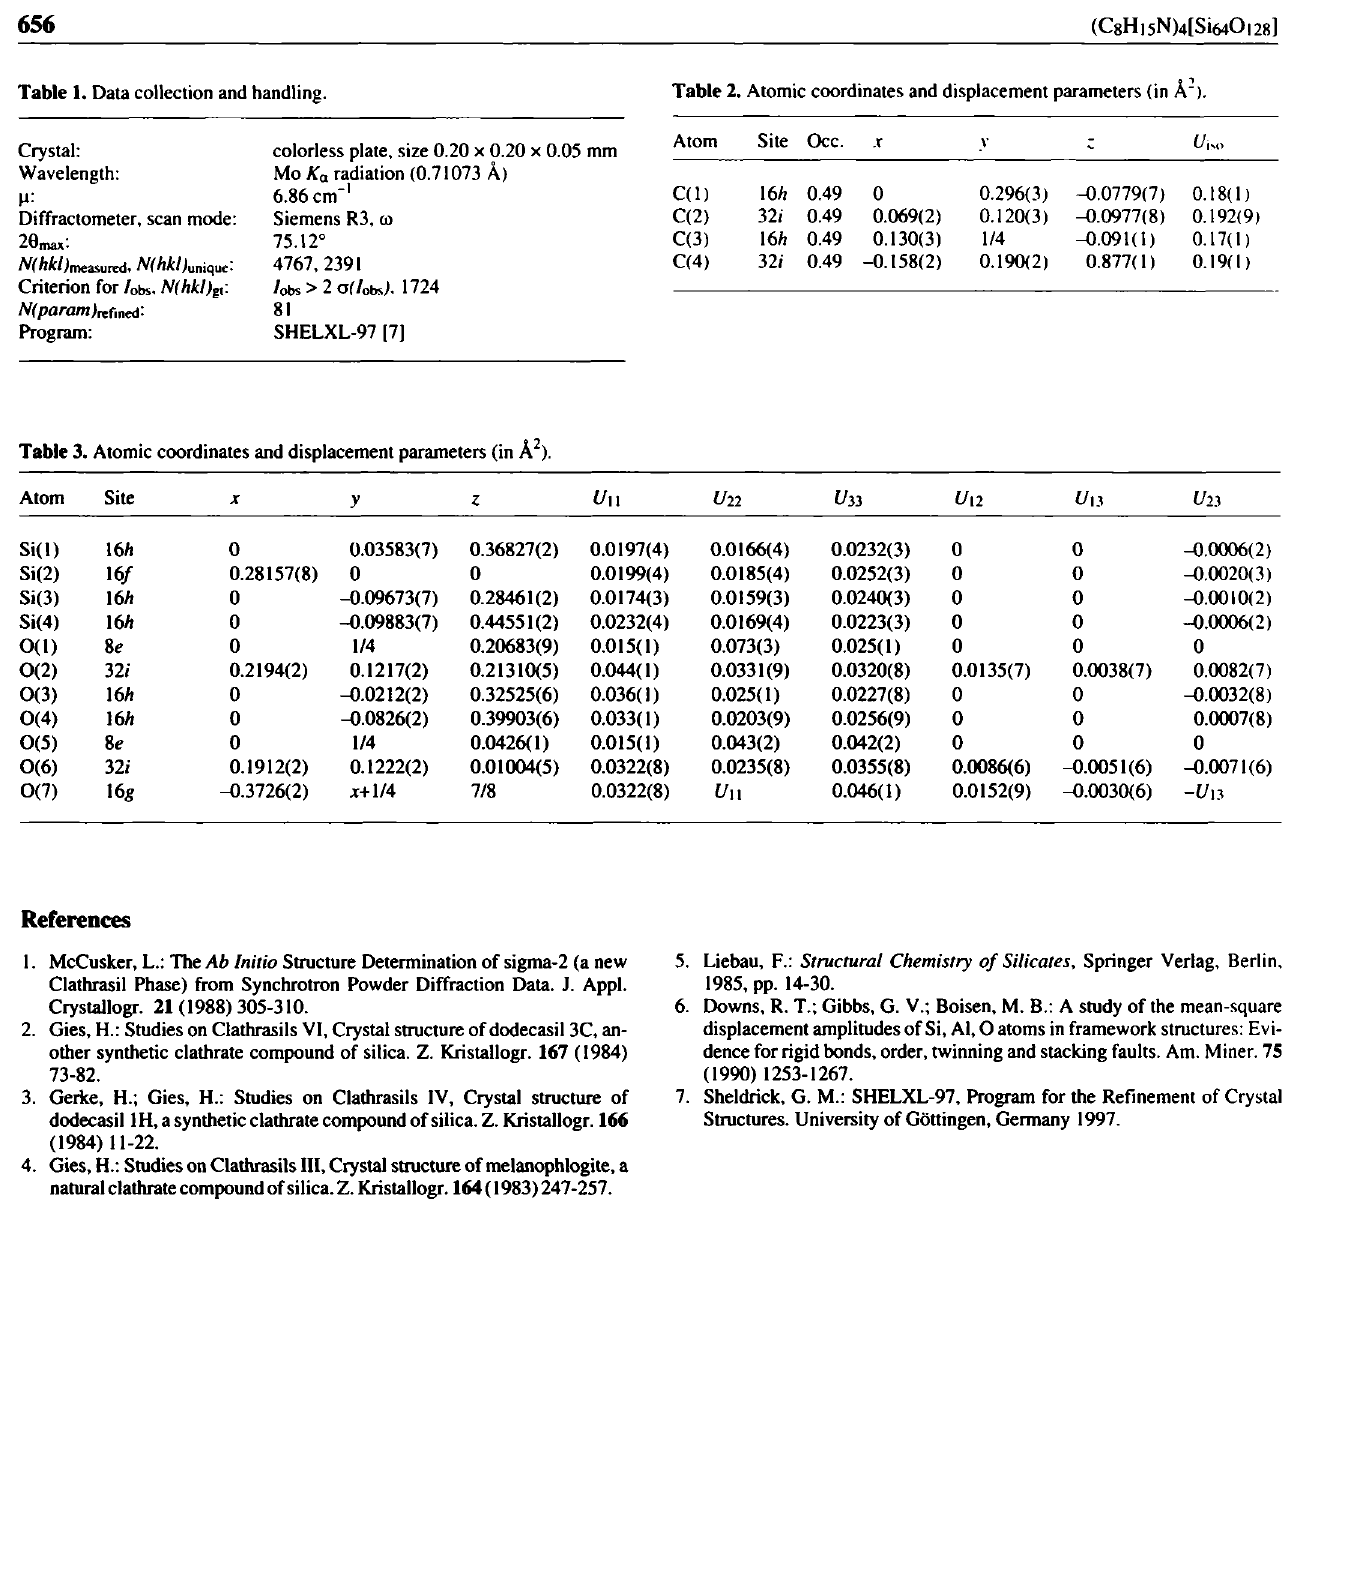
Table 1. Data collection and handling. Table 2. Atomic coordinates and displacement parameters (in Ä : ).